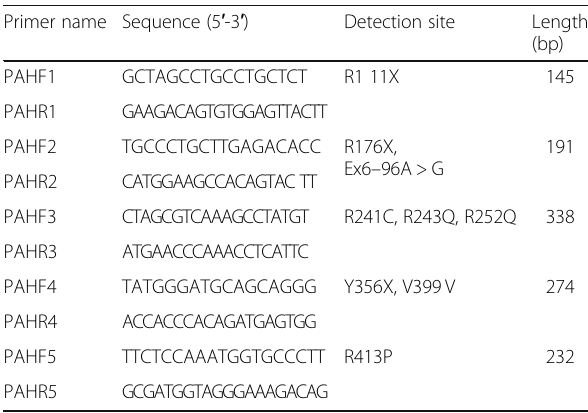
Table 1 Primer sequences and positions of single-tube multiplex PCR amplification of PAH gene fragments